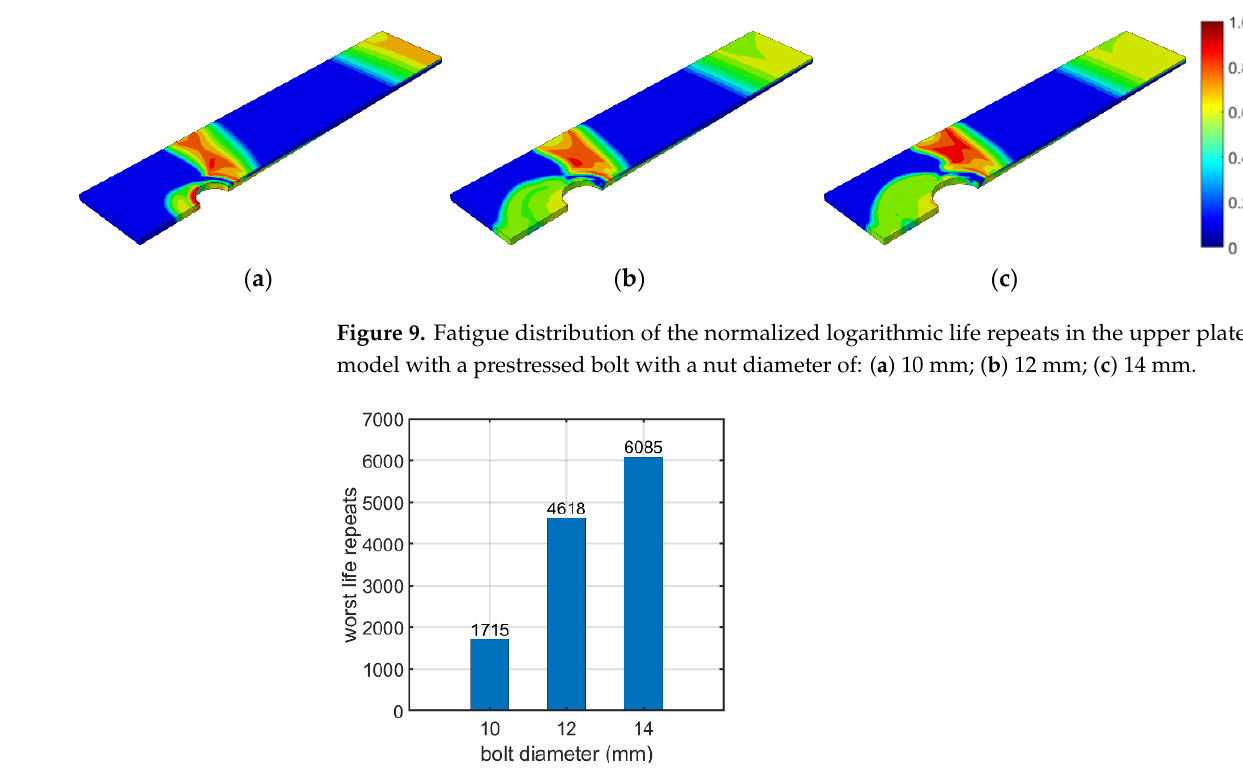
Figure 8. Fatigue distribution of the normalized logarithmic life repeats in the lower plate for the model with a prestressed bolt with a nut diameter of: ( a ) 10 mm; ( b ) 12 mm; ( c ) 14 mm.